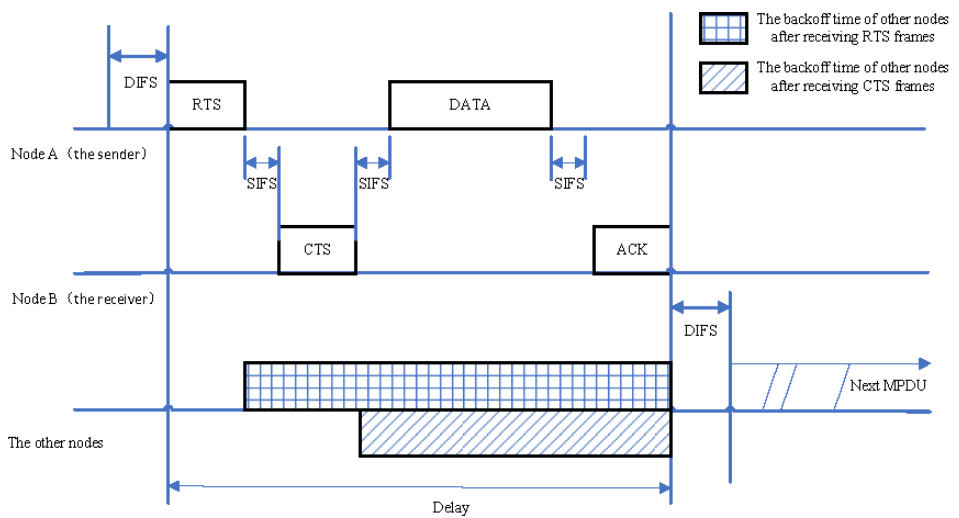
Figure 1. RTS/CTS transmission in the proposed